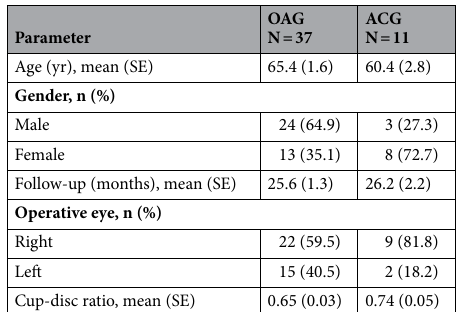
Table 1. Demographics and baseline glaucoma status in 48 eyes of 48 subjects. ACG angle-closure glaucoma, OAG open-angle glaucoma (includes primary and pseudoexfoliation open-angle glaucoma), SE standard error.